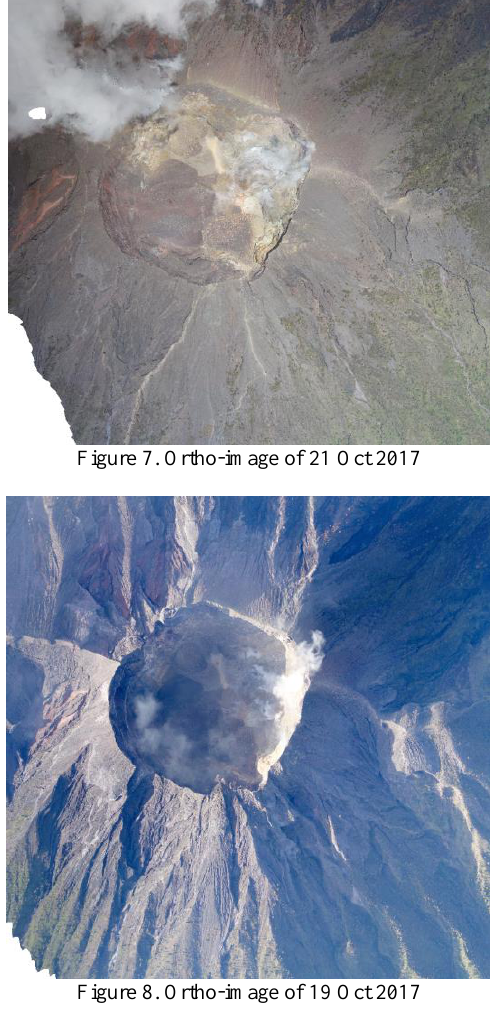
Figure 8. Ortho-image of 19 Oct 2017